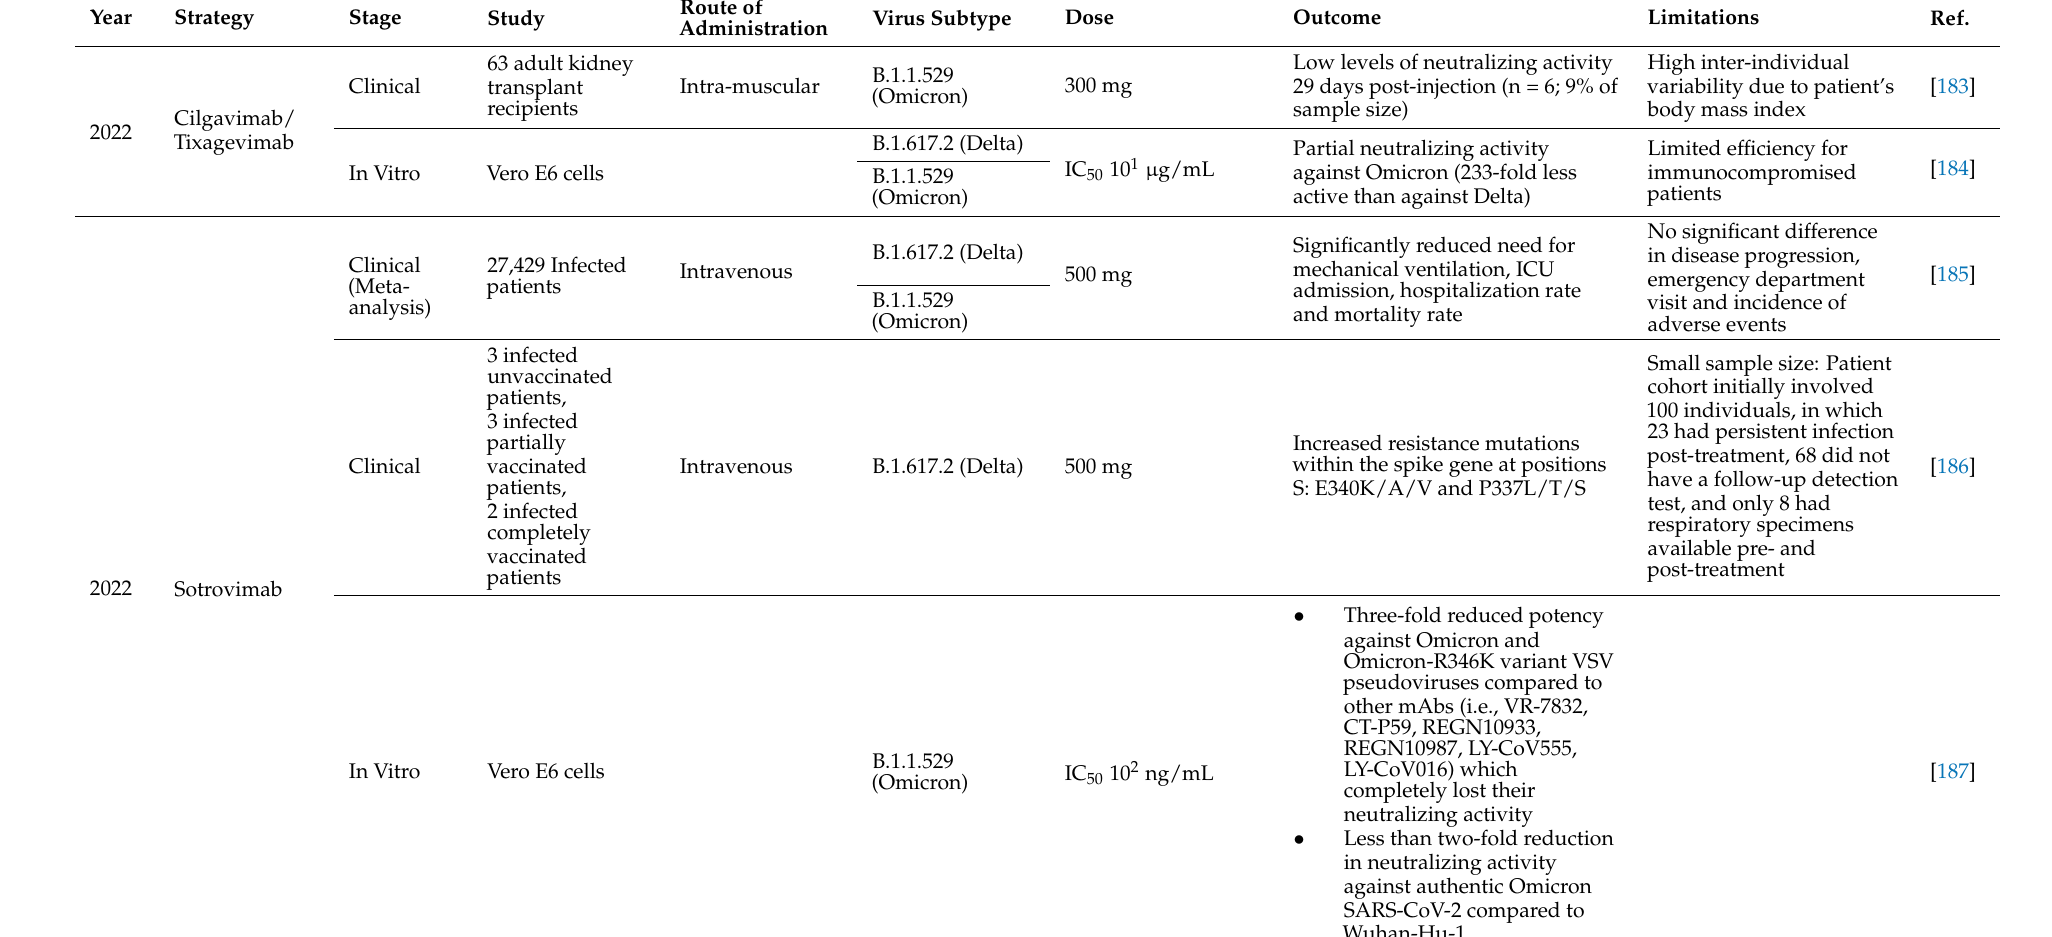
Table 2. Summary of results of treatments with monoclonal antibodies under in vitro, in vivo and clinical